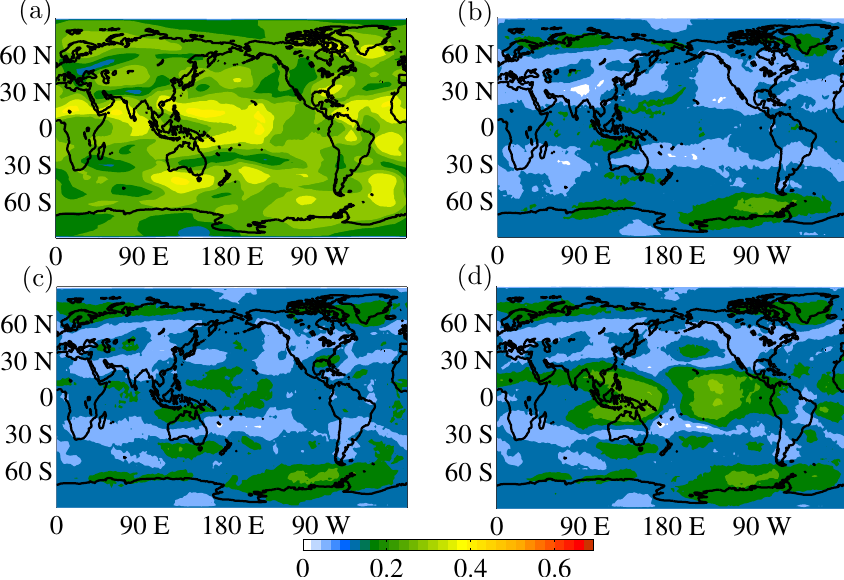
Figure 14. AWC maps of the NOAA reanalysis using data from the second period (1955–2009). The networks are built after removing one of the two principal components related to ENSO and PNA patterns. PC without ENSO-related component (a) , MI with intra-seasonal timescale without ENSO-related component (b) , and MI with intra-annual timescale without the ENSO and PNA components ( (c) and (d) ,